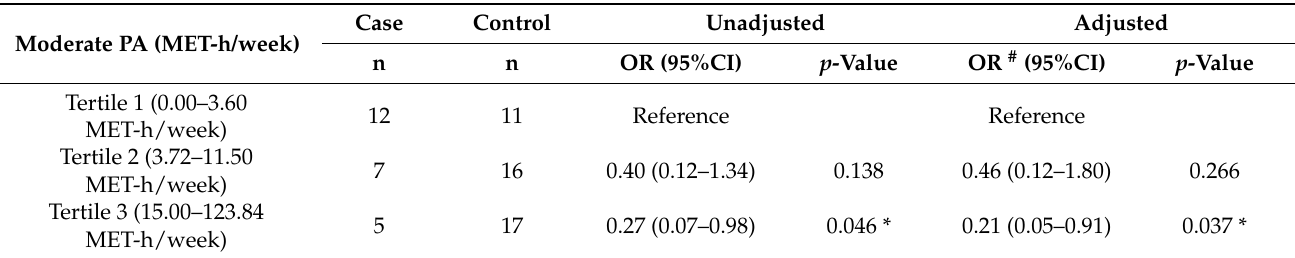
Table 3. Association between moderate-intensity physical activity during pregnancy and adverse maternal–fetal outcomes in women with gestational diabetes